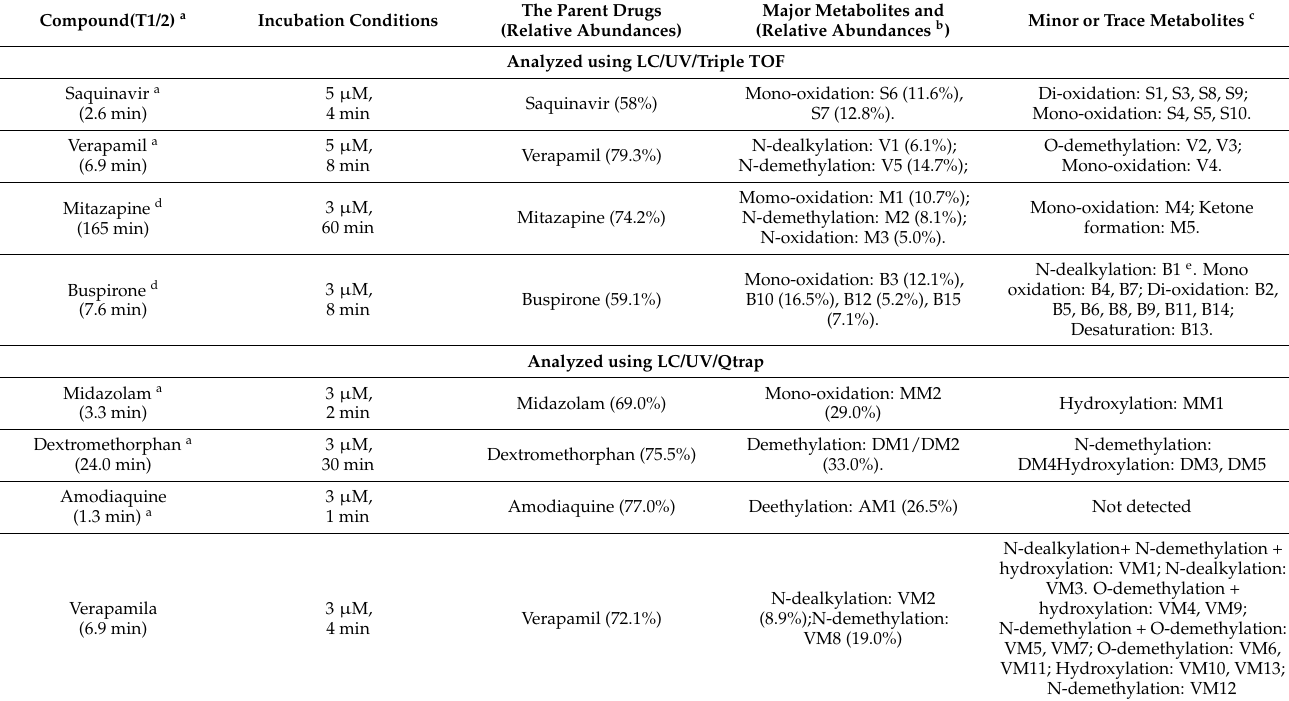
Table 1. Quantitative determination and structural characterization of metabolites of testing com- pound in HLM incubation by LC/UV/Triple TOF or LC/UV/Qtrap. Major metabolites were formed via metabolic reactions on metabolic soft